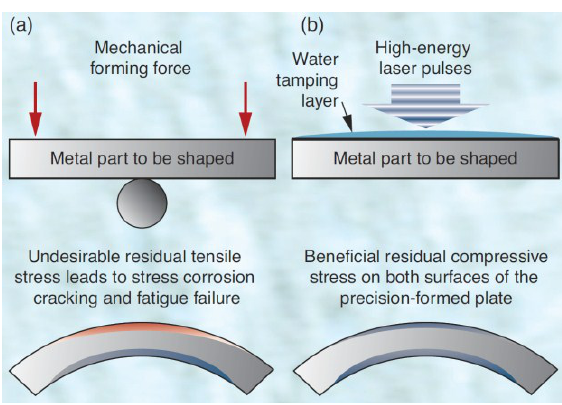
Figure 24. Comparison of ( a ) conventional and ( b ) Laser shot precision metal forming process [59].